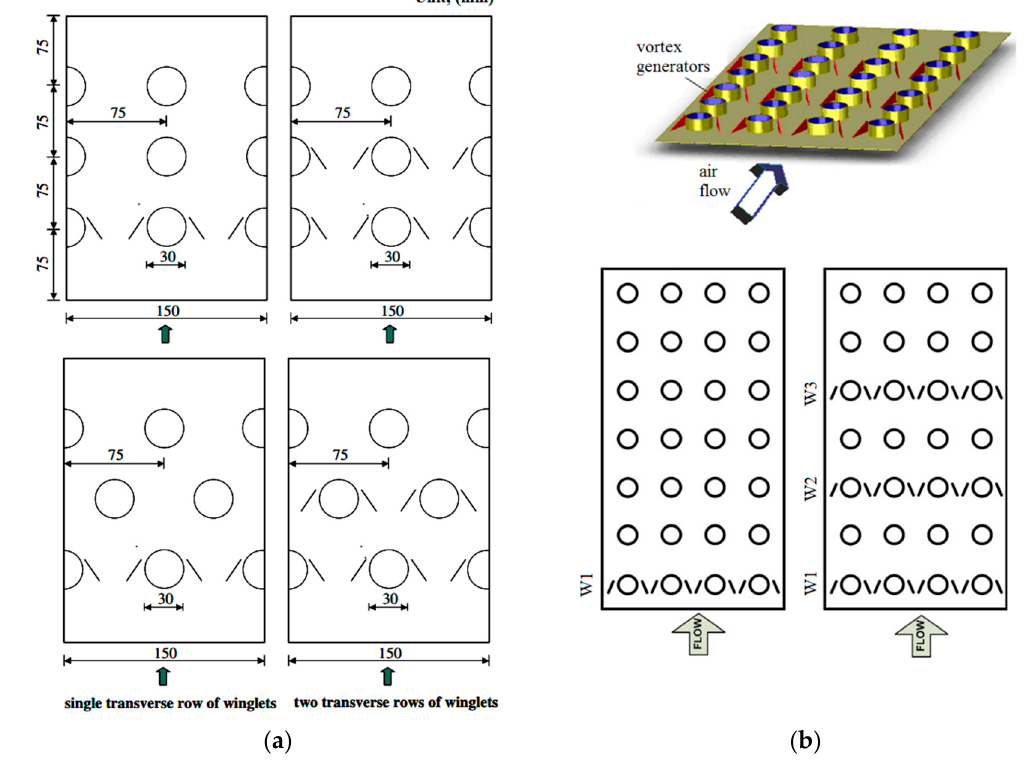
Figure 11. Geometric arrangements of tube rows and VGs. ( a ) Geometric arrangements of test core with three tube rows and VGs tested by Torii et al. [32]. ( b ) Geometric arrangements of test core with tube rows and VGs tested by Joardar and Jacobi et al. [46].